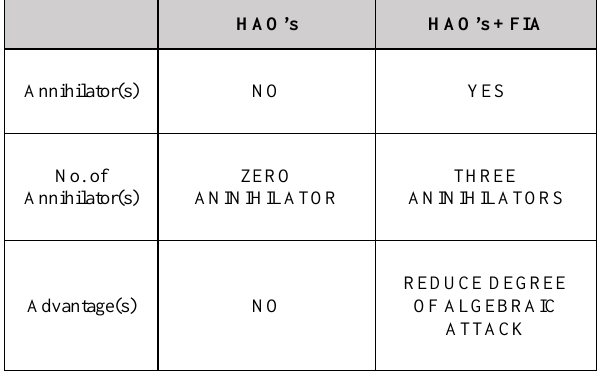
Table 7 : Comparison between finding annihilator(s) using only HAO’s algorithm and FIA+HAO’s algorithm (above).